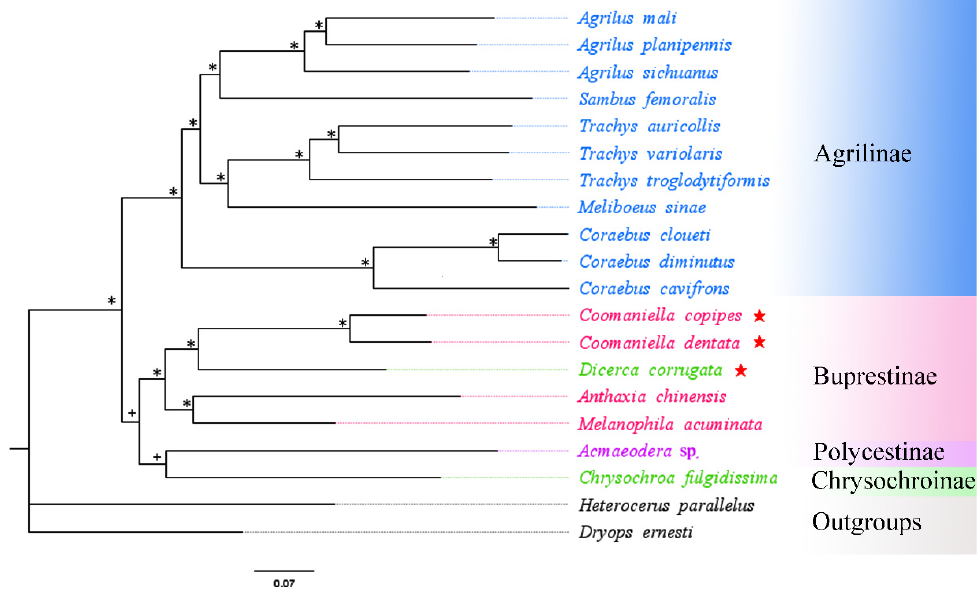
Figure 8. Phylogenetic relationships of 18 selected buprestid species using BI analyses based on 13 PCGs of mitogenomes. The symbols on branches show posterior probability (BI tree). * posterior probabilities = 1; + posterior probabilities ≥ 0.5; Red star: means species which are newly sequenced in this study.